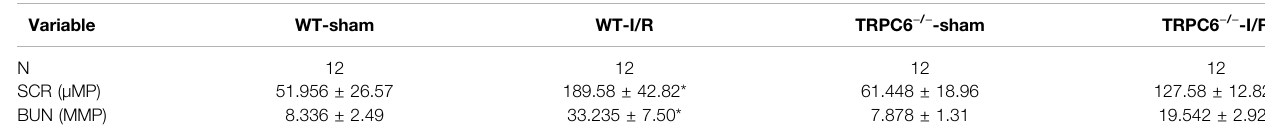
TABLE 1 | Renal function measurement of WT and TRPC6 − / − mice after 24 h reperfusion following 24 h ischemia.